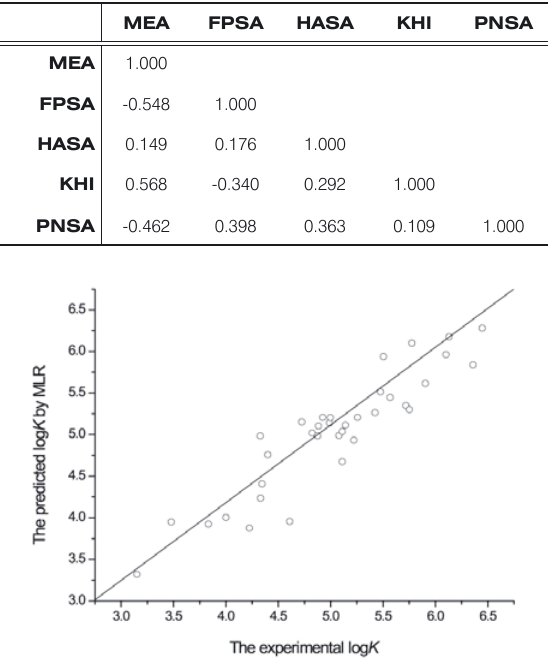
Table 3. Correlation matrix of the 5 descriptors used in the model.